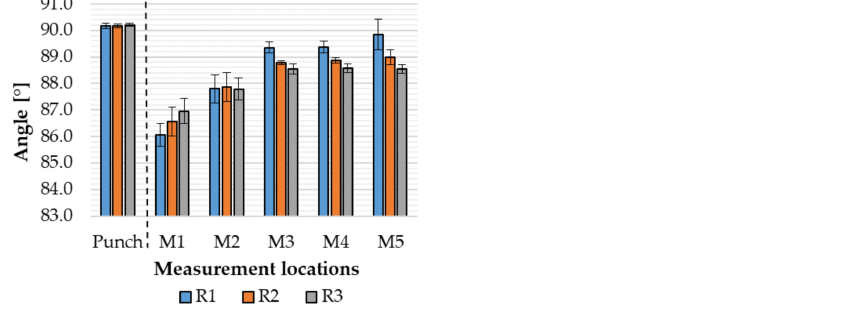
Figure 7. Measured angles as function of measurement location for tools with different nose radii.